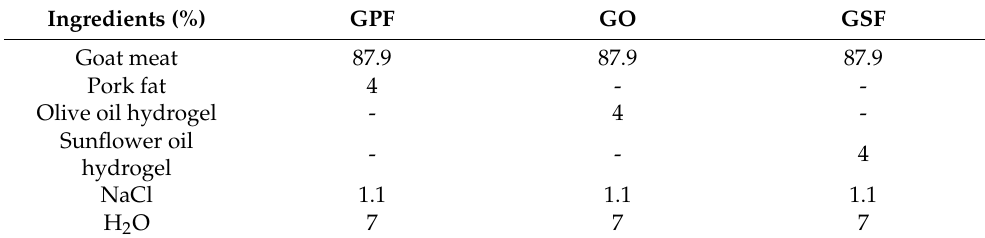
GPF: Pork fat; GO: Olive oil hydrogel emulsion; GSF: Sunflower oil hydrogel emulsion.